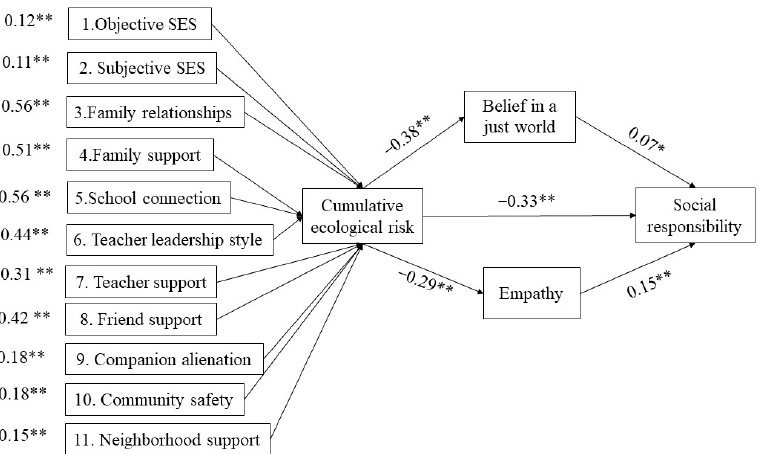
Figure 3. Explicit Mediating Model of Belief in a Just World and Empathy. Notes. ** p < 0.01.